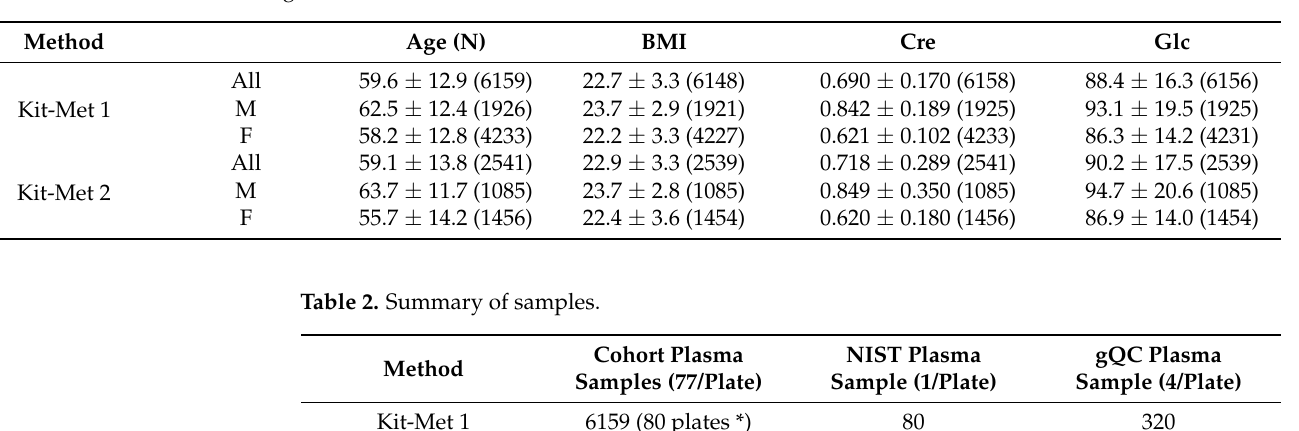
Table 1. Demographic characteristics of participants. The values were mean ± SD. Averrable numbers of each parameter from database are shown in the column (N). All, all subjects; M, male; F, female; BMI, body mass index; Cre, blood test creatinine; Glc, blood test glucose.